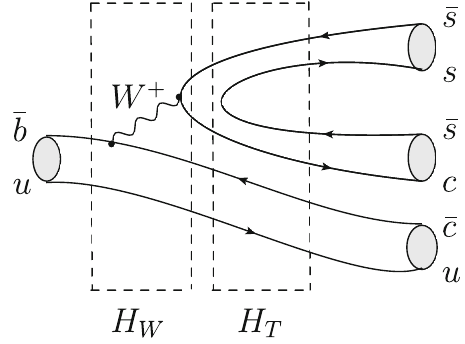
Fig. 1 The production mechanism of Z cs in the B meson decay